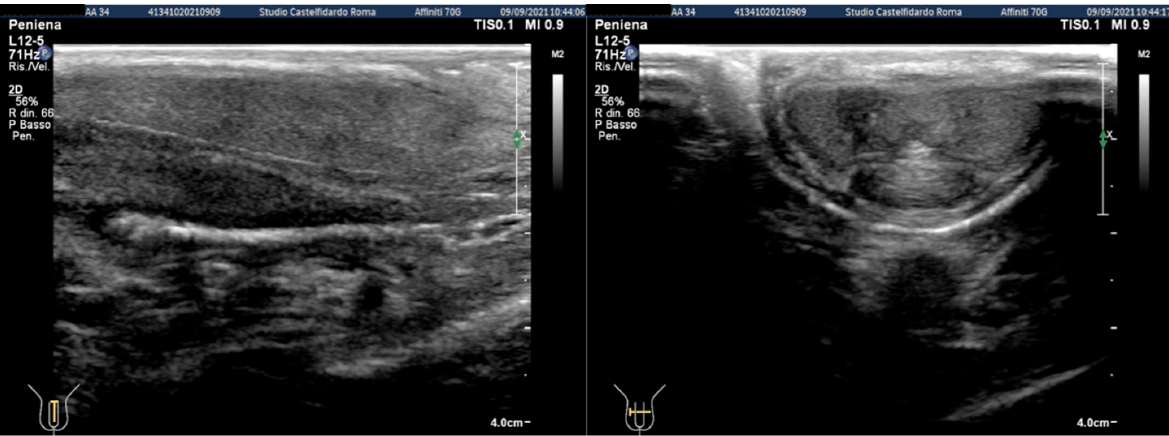
Figure 5. Ultrasonography of the penis after the third treatment cycle (longitudinal and transverse